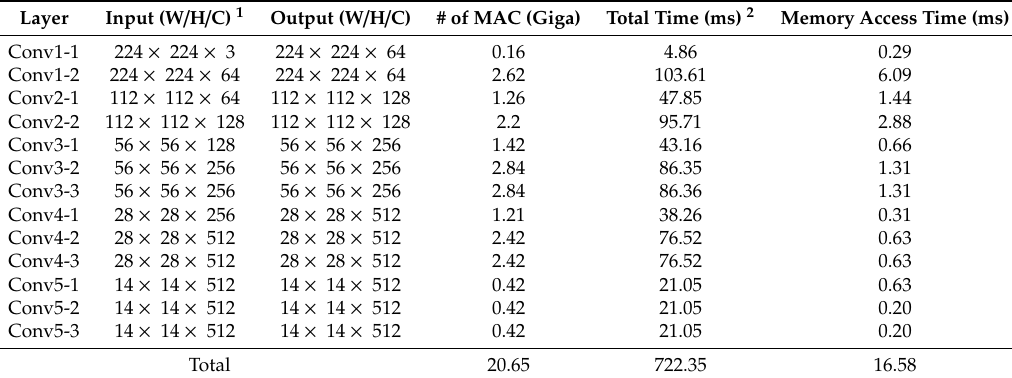
Table 5. Inference performance of VGG-16 with 4 × 4 sized kernels and batch size 1.